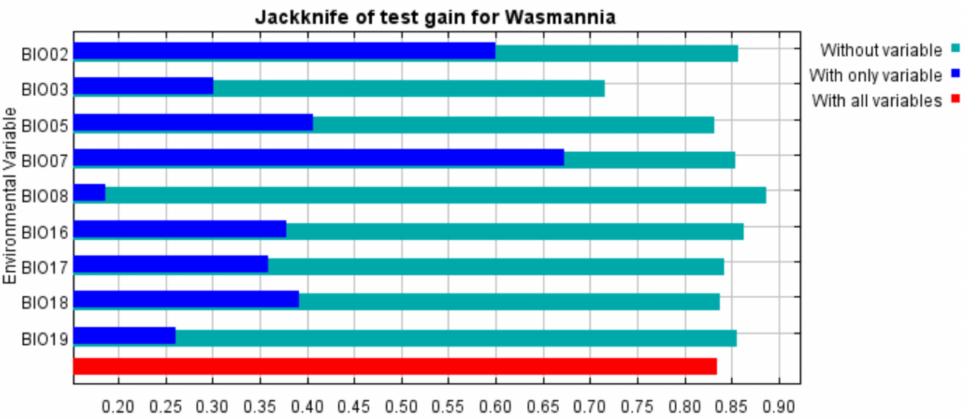
Figure 3. Jackknife test gain for W. auropunctata . Blue, green, and red bars represent running the MaxEnt model with the variable alone, without the variable, and with all variables, respectively.